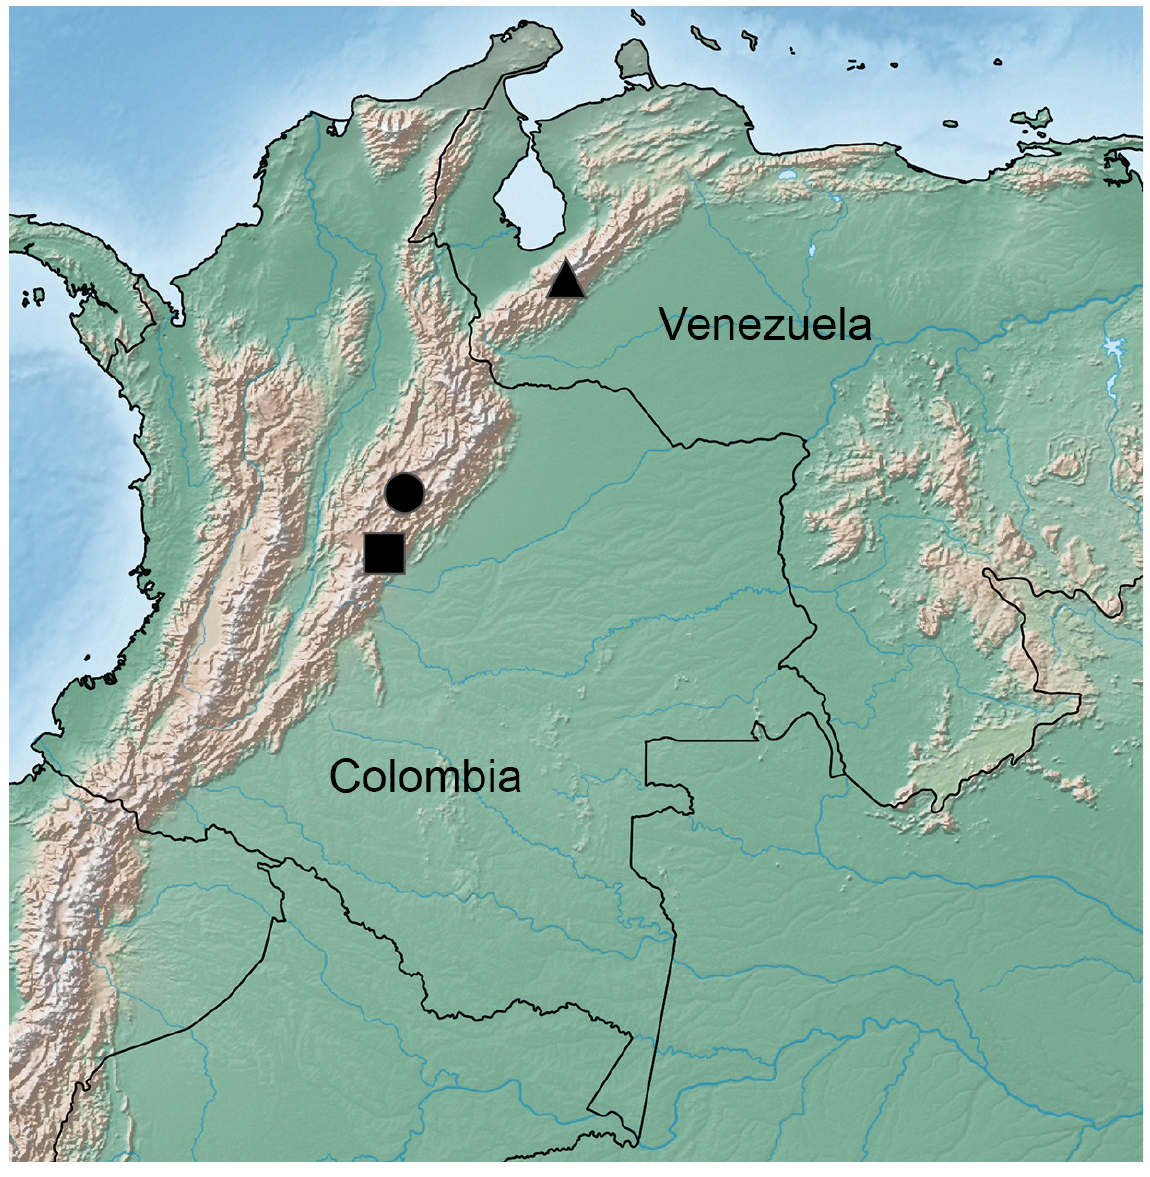
Fig. 6. Distribution map of Ikaros apteros gen. et sp. nov. (square), I. paramo gen. et sp. nov. (circle) and I. polygonos gen. et sp. nov.